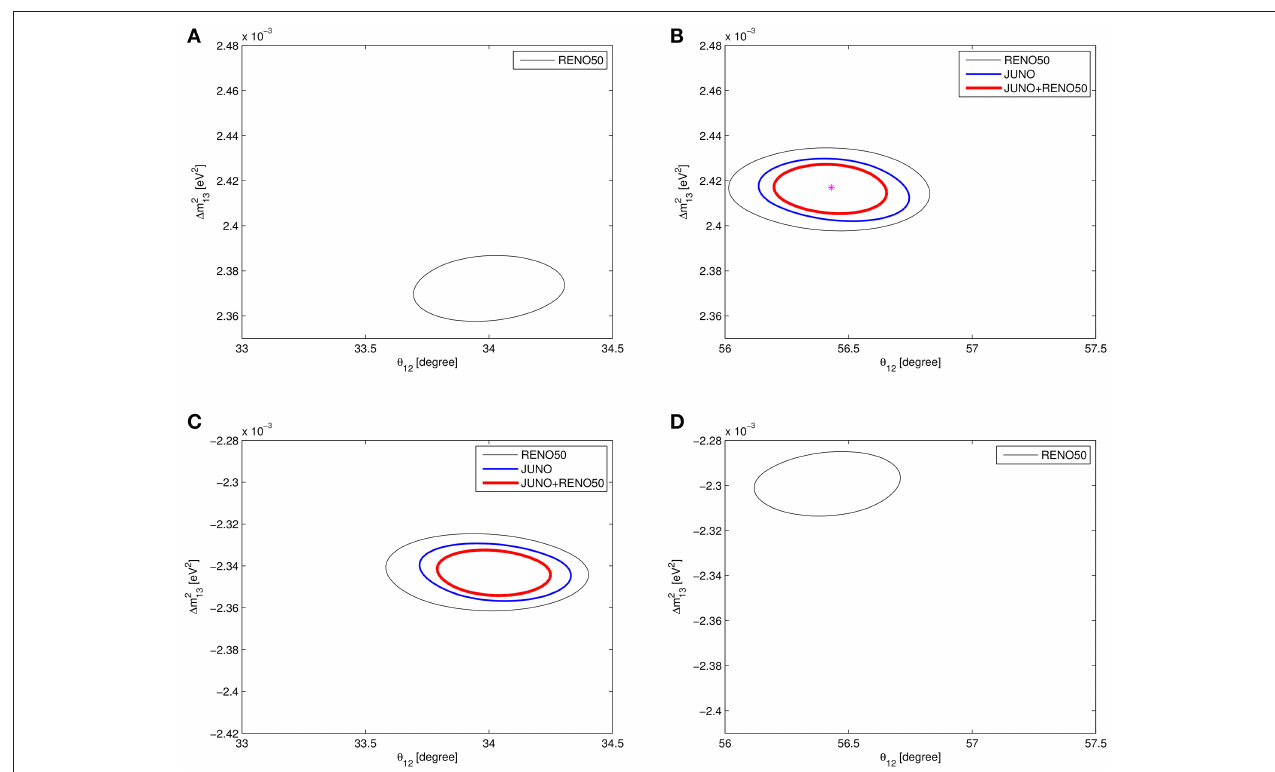
FIGURE 16 | The same as Figure 15 except that the true values are taken to be 1 m 2 31 solution is assumed to be true. Panel (B) shows the true solution. Panels (A,C,D) show degenerate solutions respectively with opposite octant, with opposite mass ordering and with both opposite octant and mass ordering. Plots are taken from Bakhti and Farzan [19], published under the terms of the Creative Commons Attribution Noncommercial License and therefore no copyright permissions were required for their inclusion in this